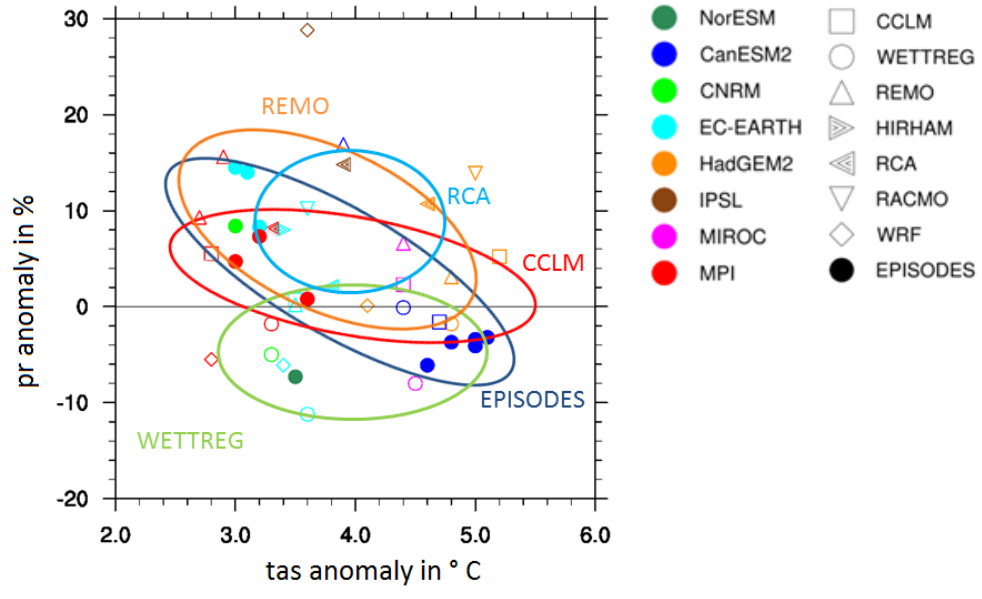
Figure 1. Comparison of the results of different downscaling methods based on CMIP5 for Germany depicted as a Thermo-Pluviogram. The symbols compare the Germany-wide mean climate change signal in annual precipitation (pr) and temperature (tas) under RCP8.5 for 2071–2100 with respect to 1971–2000. Different colours correspond to different Global Climate Models (GCMs), while different marker styles label different downscaling methods. The ellipses are added for guidance to highlight the method-specific relation between temperature increase and precipitation change. Based on data from the EURO-CORDEX [15] and ReKliEs-De project